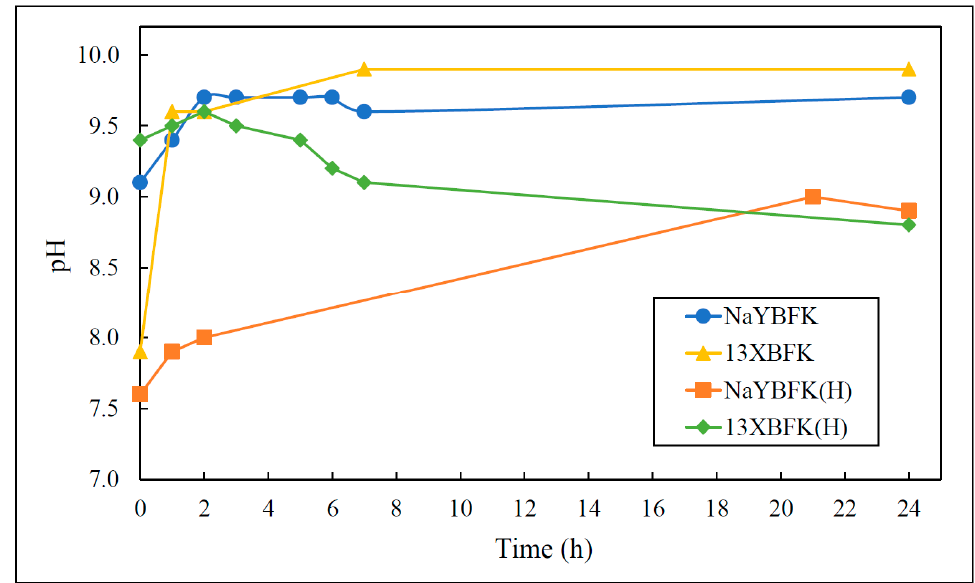
Figure 3. pH measurements of the different adsorbent materials suspended in distilled water over time, with a dose of 1 g/L.